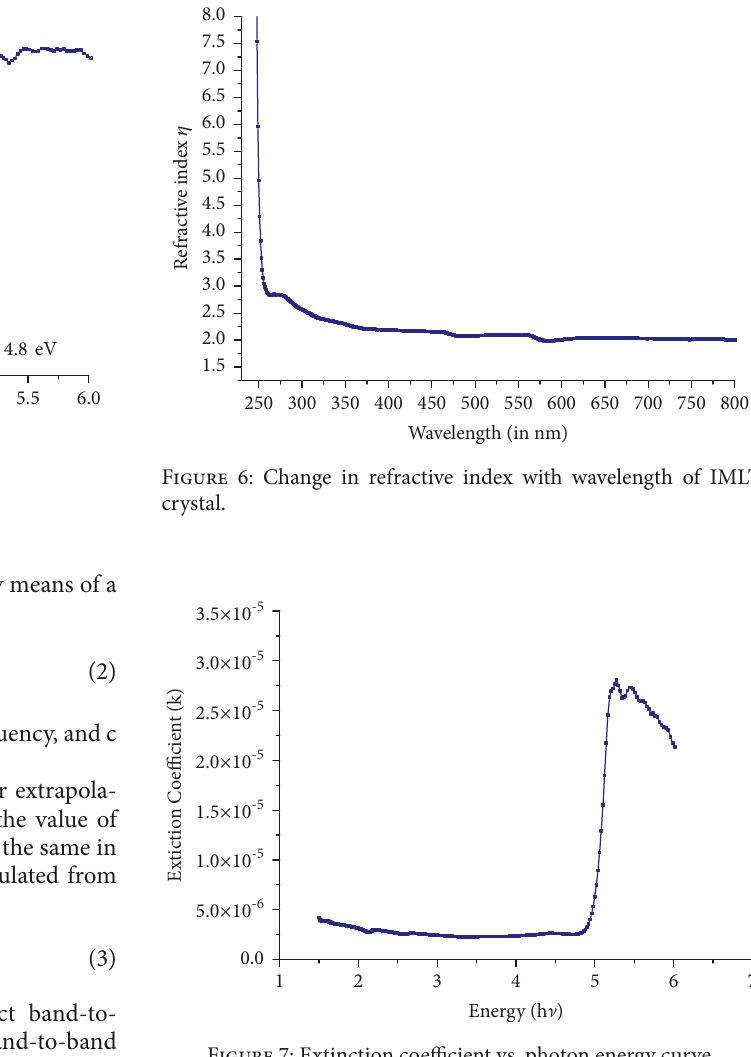
Figure 7: Extinction coefficient vs. photon energy